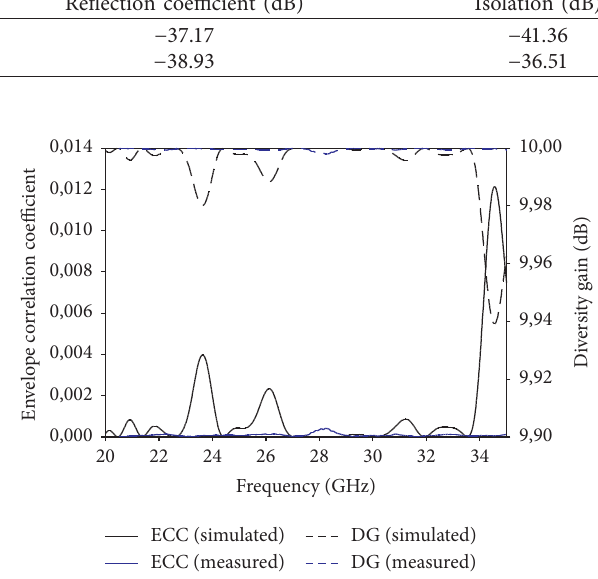
Figure 14: ECC and DG of the proposed MIMO antenna.